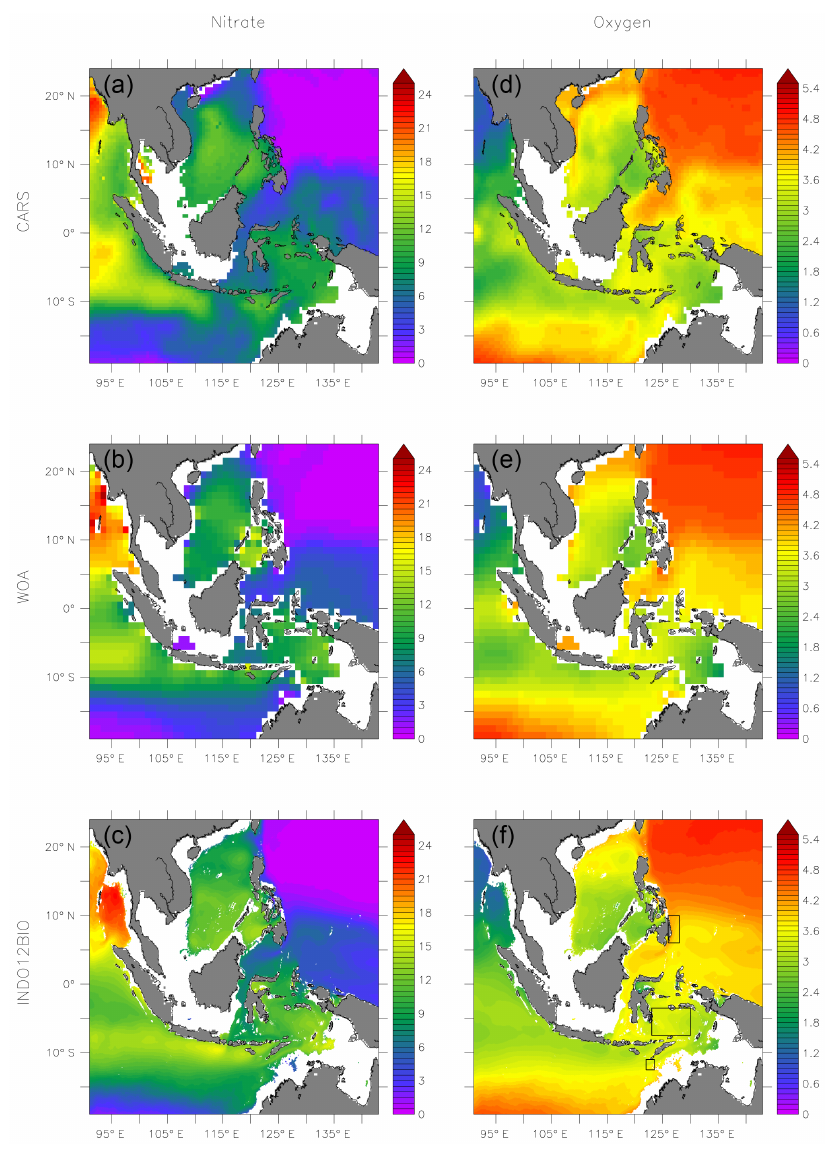
Figure 2. Annual mean of nitrate (mmolNm − 3 ; left) and oxygen concentrations (mLO 2 L − 1 ; right) at 100m depth from CARS (a, d) and WOA ( b , e ; statistical mean) annual climatologies, and from INDO12BIO as 2010–2014 averages (c, f) . Three key boxes for water mass transformation (North Pacific, Banda, and Timor; Koch-Larrouy et al., 2007) were added to the bottom-right